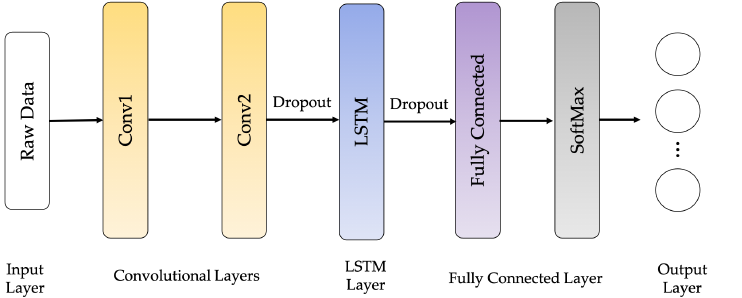
Figure 13. CNN-LSTM network architecture.